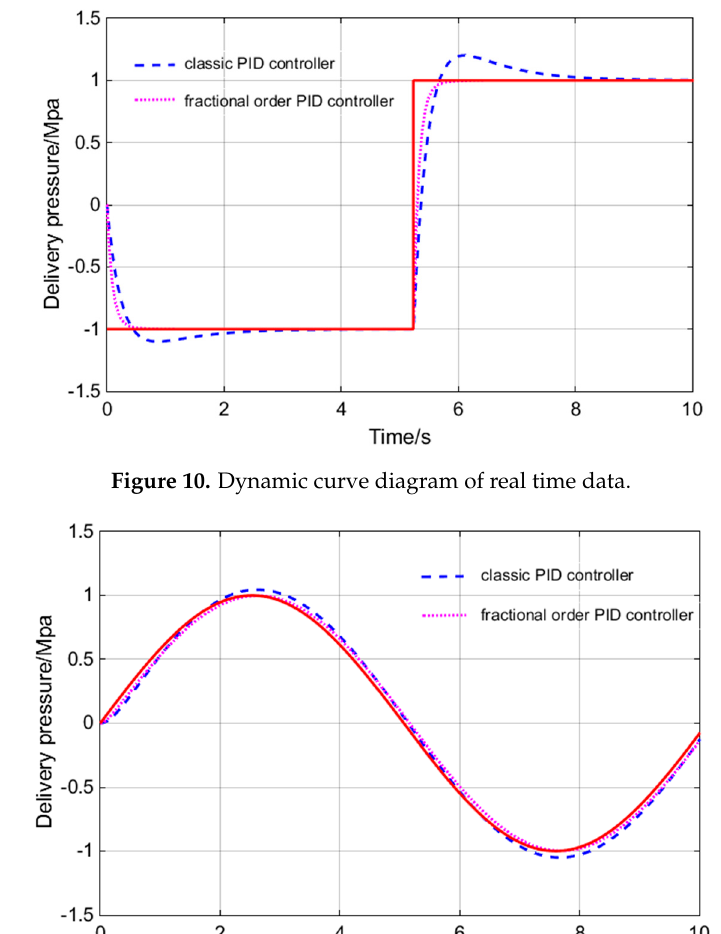
Figure 9. Main mechanism of Journal bearing test rig.